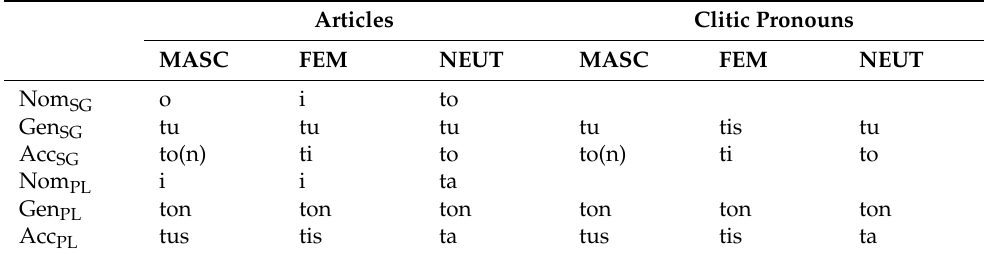
Table 4. SMG definite articles and clitic